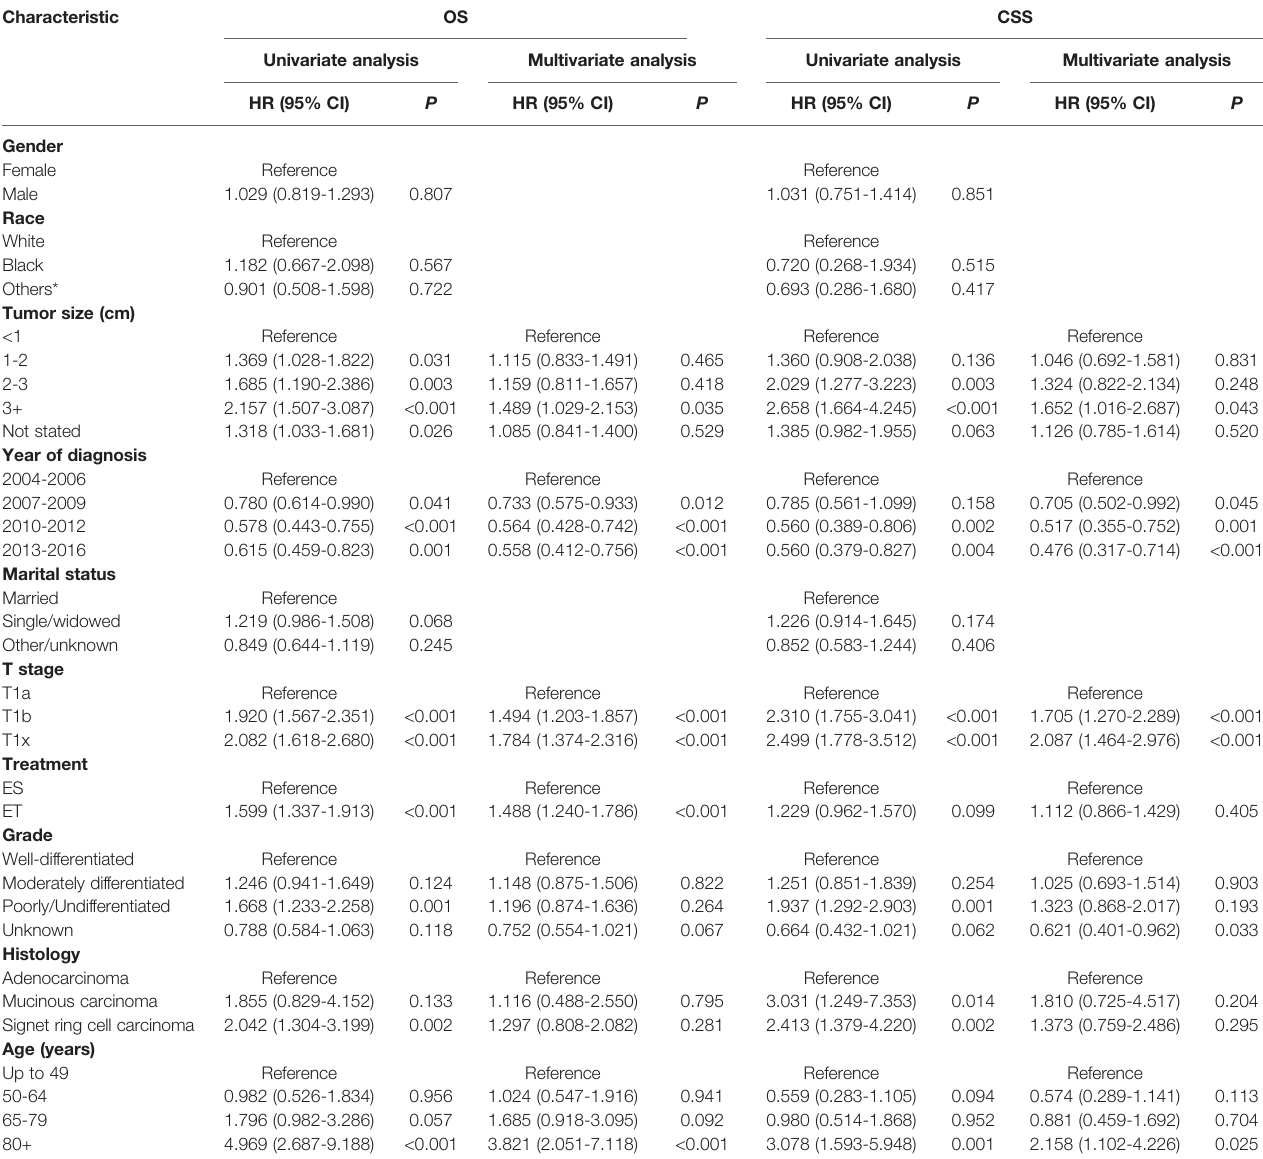
TABLE 5 | Cox regression analysis of OS and CSS in patients with early-stage esophagogastric junction cancer after propensity score matching.